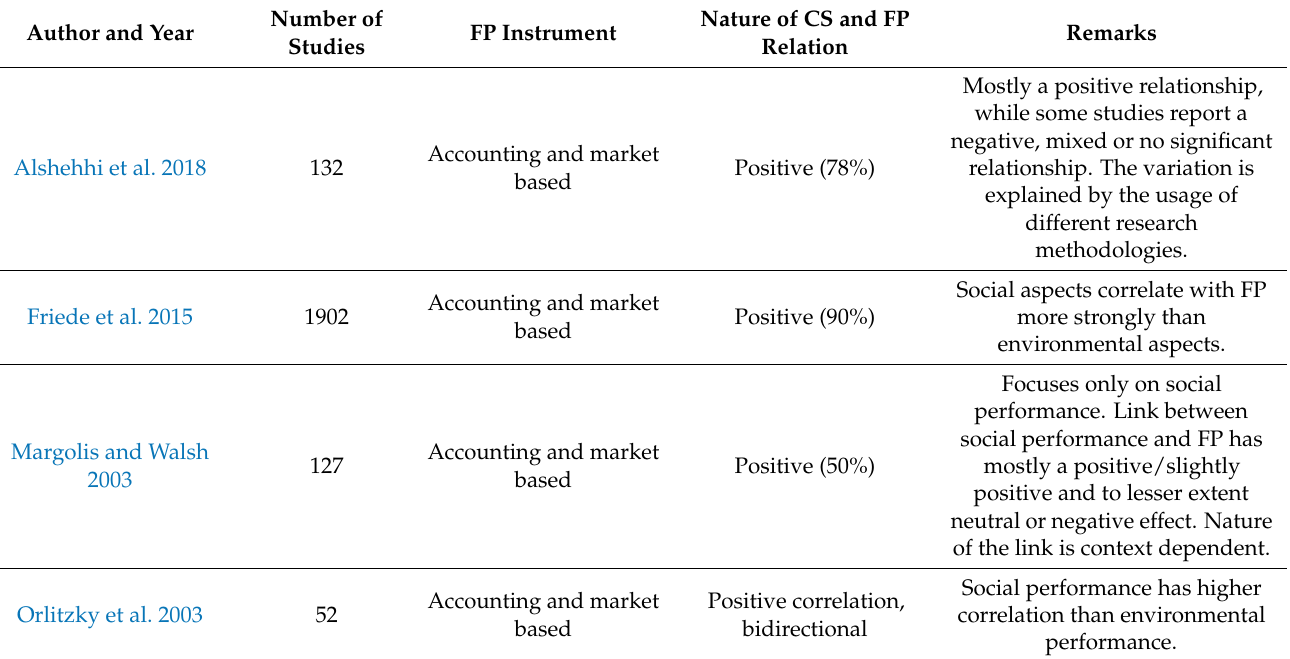
Table 1. Overview of meta-analyses on the corporate sustainability (CS) and financial performance (FP)